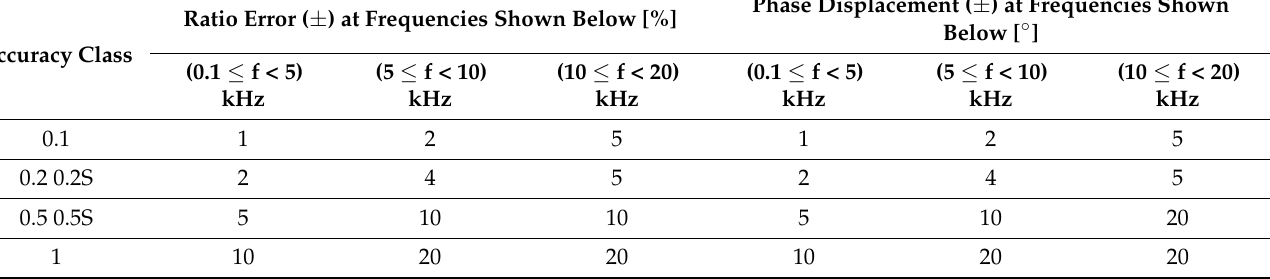
Table 3. Accuracy classes extension for high bandwidth DC applications